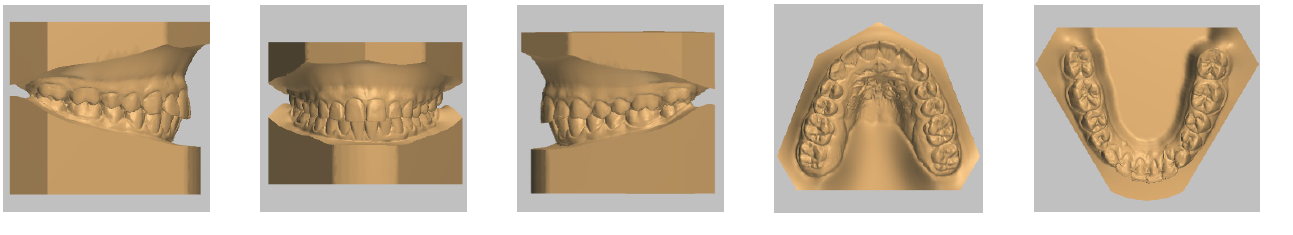
Figure 12. Post-treatment facial and intraoral photographs.